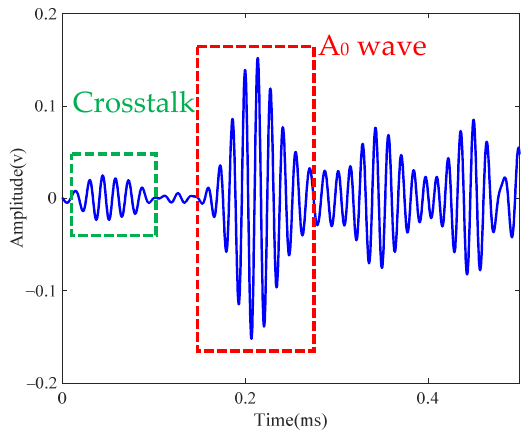
Figure 19. Scattered signal of single-damage case.